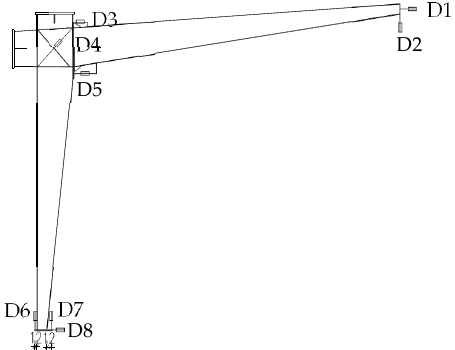
Figure 5. Layout of displacement gauges D1 to D8.